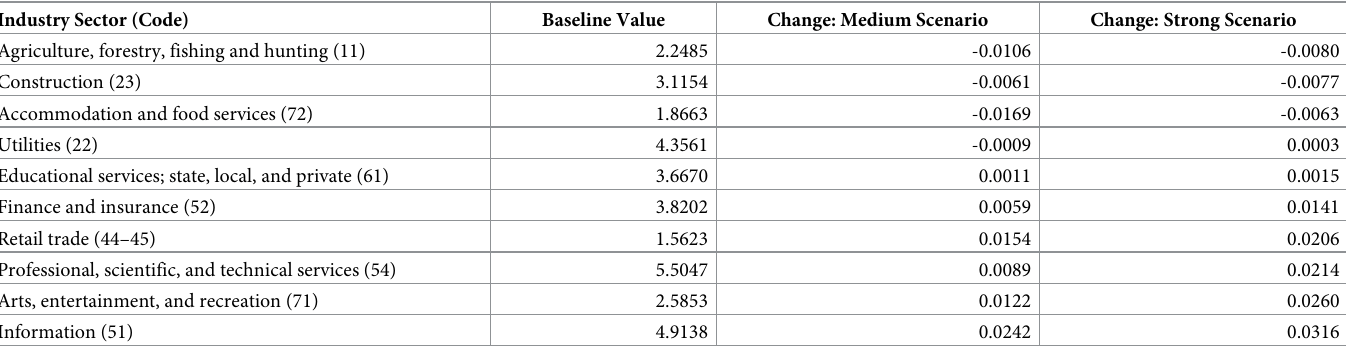
Table 8. Projected changes in social IWAs per worker by 2-digit industry sector.